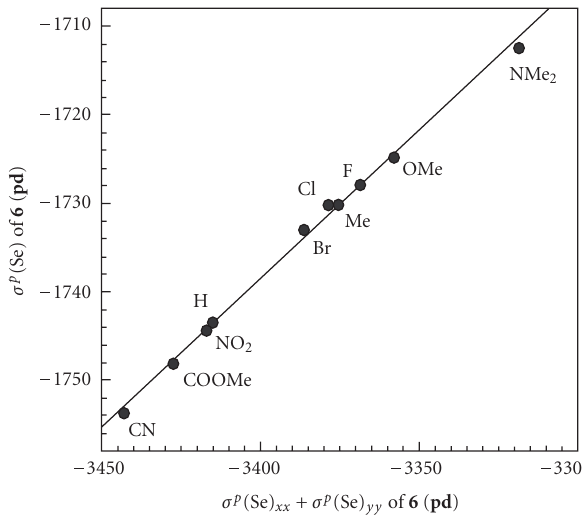
Figure 4: Plot of σ p (Se) versus σ p (Se) xx + σ p (Se) yy for 6 ( pd ). performed on 4 – 6 in pl and pd at the density functional theory (DFT) level of the Becke three parameter hybrid functionals combined with the Lee-Yang-Parr correlation functional (B3LYP). Absolute magnetic shielding tensors of Se nuclei ( σ (Se)) are calculated based on the gauge- independent atomic orbital (GIAO) method, applying on the optimized structures with the same